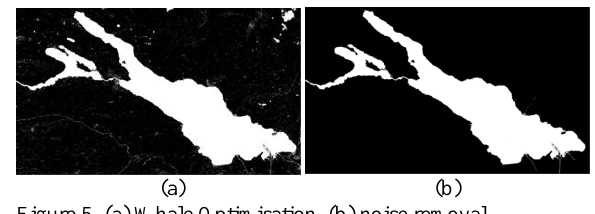
Figure 5. (a) Whale Optimisation, (b) noise removal